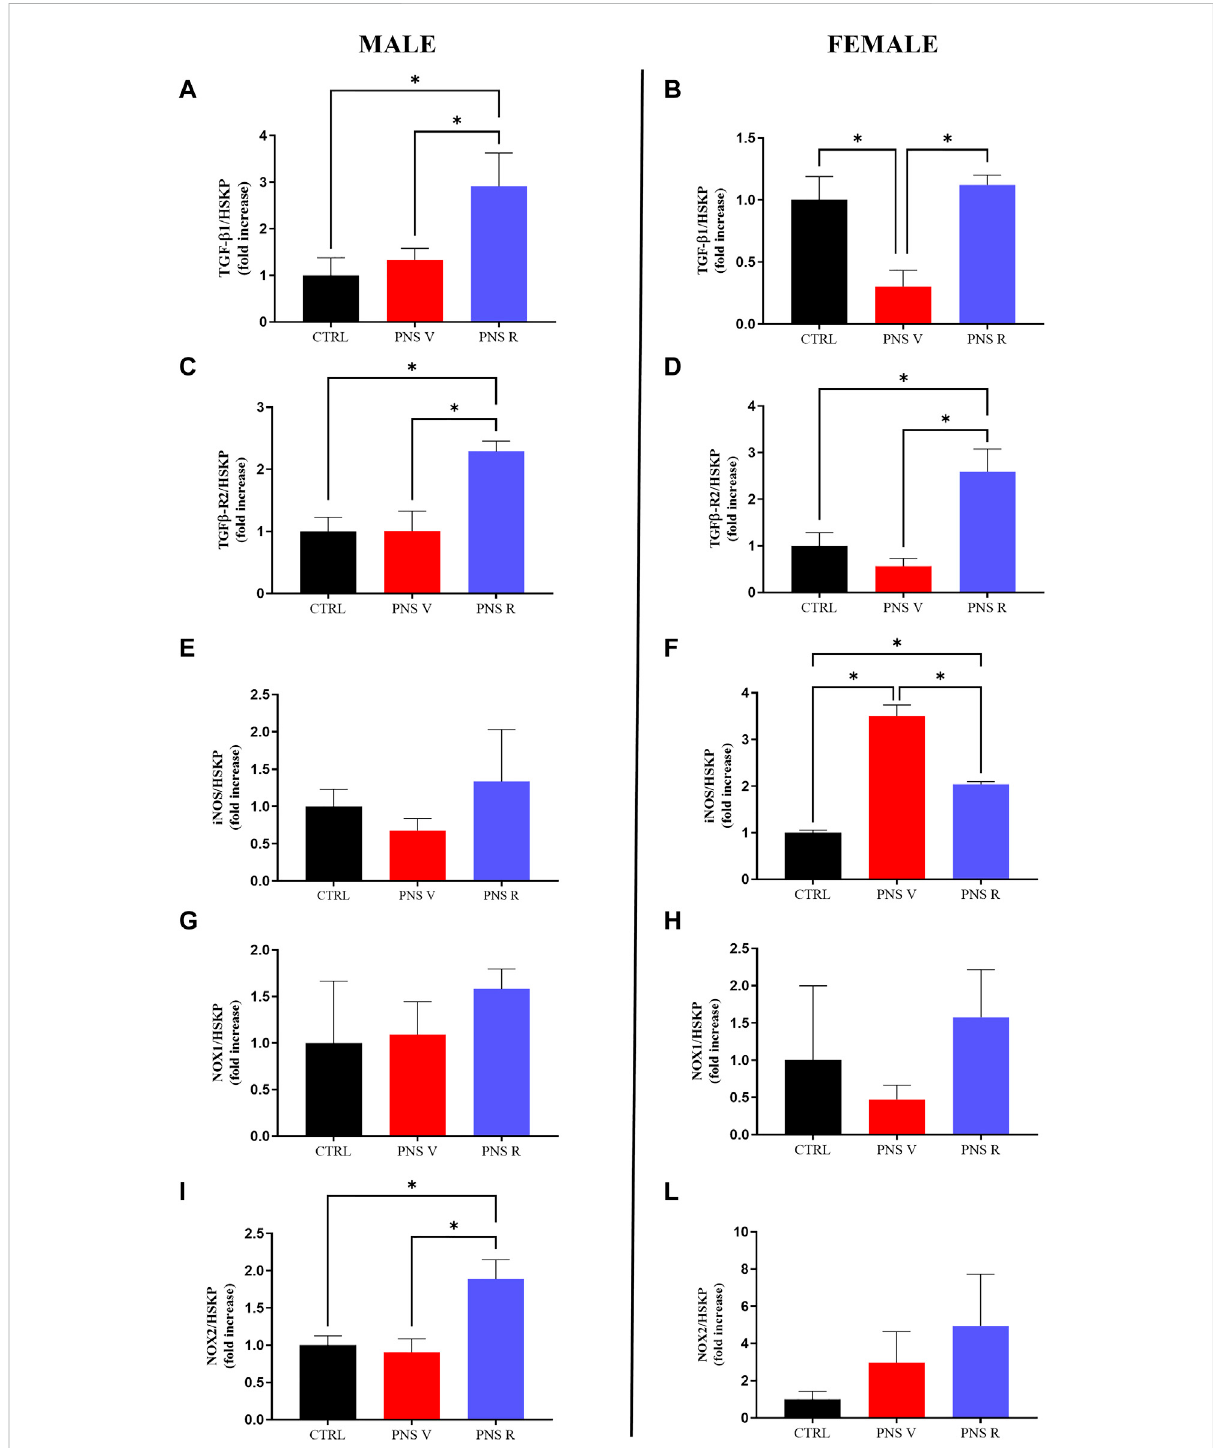
Effects of PNS on gene expression in the hippocampus: impact on TGF- β 1 pathway and oxidative stress machinery. Effects induced by PNS exposureon (A,B) TGF- β 1, (C,D) TGF β -R2, (E,F) iNOS, (G,H) NOX1,and (I,J) NOX2mRNAsexpressionmeasuredbyqRT-PCR.Theabundanceofeach mRNA of interest was expressed relative to the abundance of GAPDH/ β -actin (HSKP) mRNA, as endogenous controls. As a negative control, a reaction in absence of cDNA (no template control, NTC) was performed. qRT-PCR ampli fi cations were performed at least in triplicate. Data are shown as mean ± S.E.M. * p <